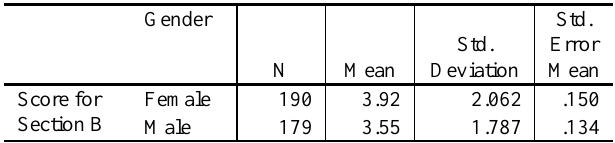
Table 4: Knowledge score according to gender